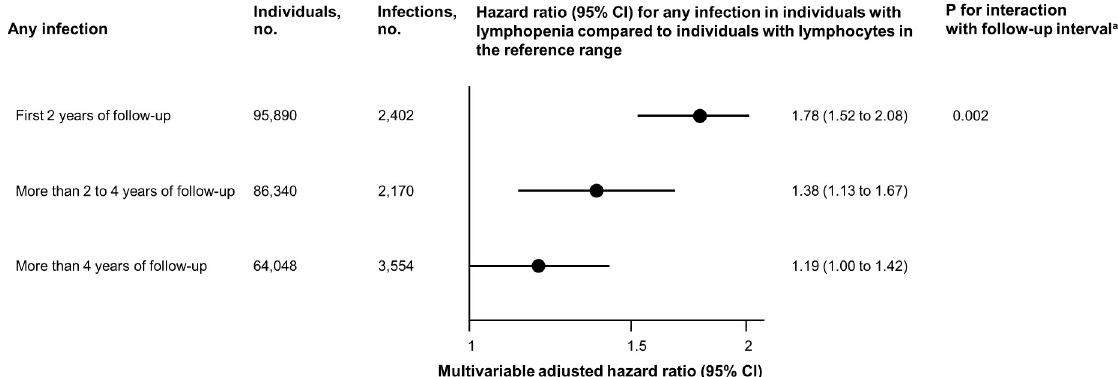
Fig 7. Multivariable adjusted risk of any infection for individuals from the Copenhagen General Population Study with lymphopenia stratified by follow-up time. Multivariable adjusted risk of any infection for individuals from the Copenhagen General Population Study with lymphopenia (lymphocyte count < 1.1 × 10 9 /l) compared to individuals with lymphocyte count in the reference range (1.1–3.7 × 10 9 /l). Multivariable adjustment includes all covariates listed in Table 1 except age, but with age as the underlying timescale. Follow-up time was segmented into 3 time intervals, and each individual was included in more than 1 time interval if total follow-up was above 2 years. When categorizing lymphocyte counts, lymphopenia was defined as a lymphocyte count below the 2.5th percentile, while the reference category was defined as a lymphocyte count between the 2.5th and 97.5th percentile. a According to a likelihood ratio test.